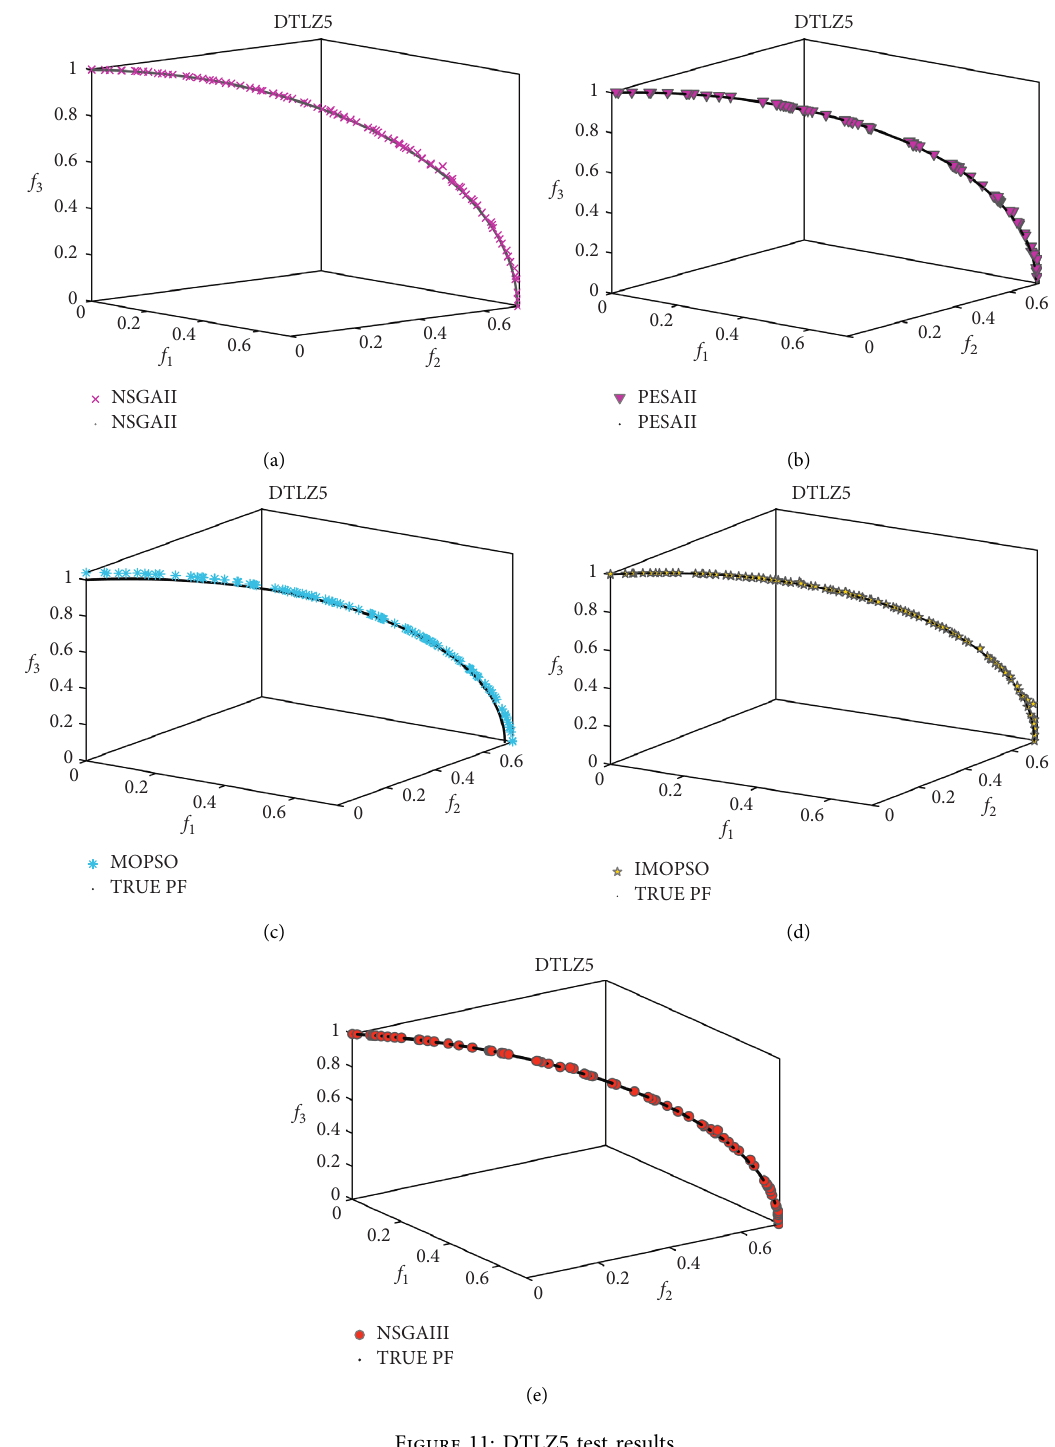
Figure 11: DTLZ5 test